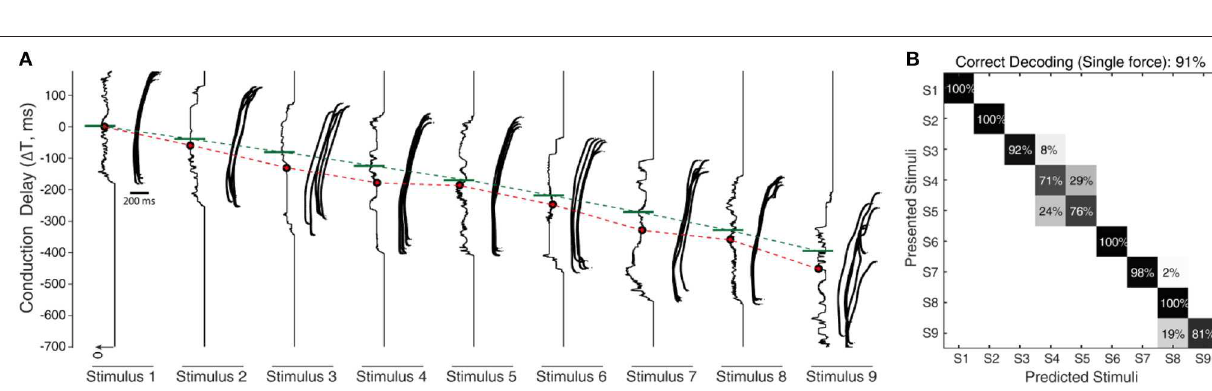
FIGURE 6 | Classification of CNs responses irrespective of sensing forces. (A) Spiking probability across all the nine stimuli and five different sensing forces ( Figure 3C ), for each conduction delays. These CNs responses are for a single sensing velocity (5 mm/s). This plot clearly demonstrates almost similar spiking probability, robust to the variation of the sensing force, thus supporting generalization ability of the proposed approach. (B) Confusion matrix illustrating the decoding performance achieved by CNs irrespective of forces (labeling stimuli irrespective of sensing force), across all the 9 stimuli. The decoding accuracy was 100% across 5 stimuli with a step size of 10 ◦ (S1, S3, S5, S7, and S9), and 94.5% with a step size of 5 ◦ .